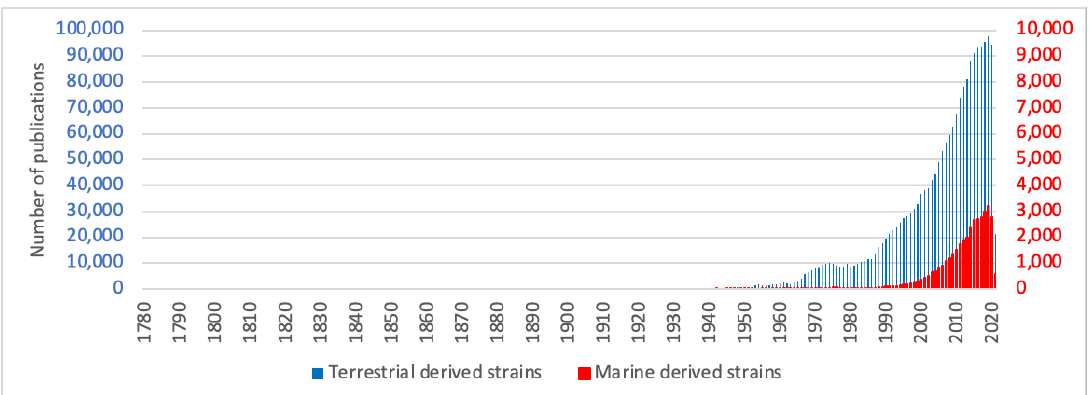
Figure 2. Evolution of the number of publications available on PubMed for terrestrial fungi (blue) and marine fungi (red) over the years (keywords used for PubMed research: (blue) “fungi” NOT “marine”, (red) “fungi” AND “marine”; “fungi” NOT “marine” excludes marine fungi from the research while “fungi” AND “marine” only selects strains from marine environment).